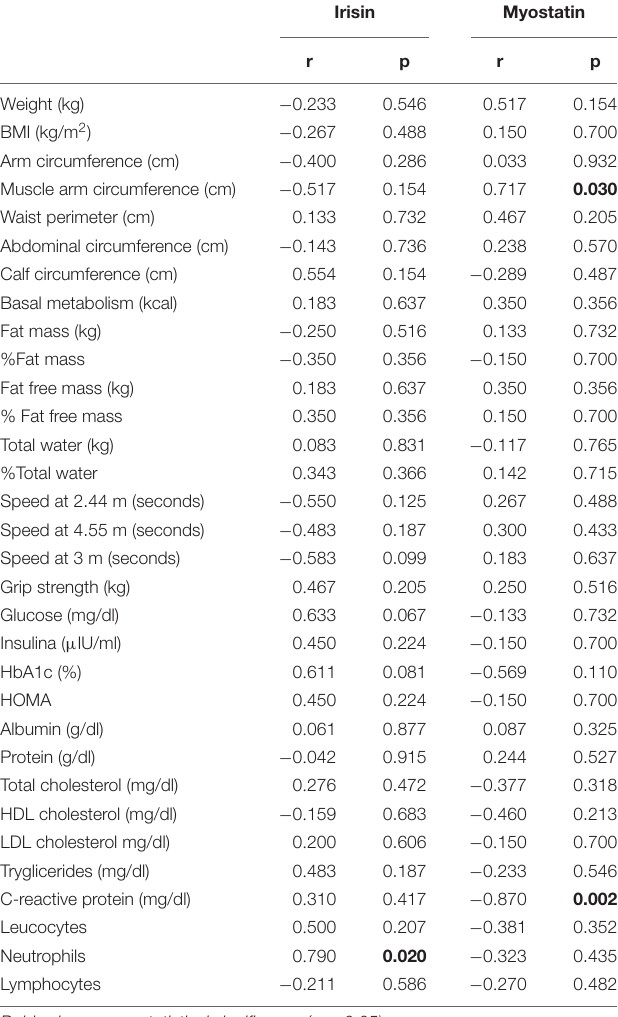
TABLE 8 | Bivariate correlations between anthropometrical and clinical parameters and circulating irisin and myostatin in resistance exercise and nutritional support group at